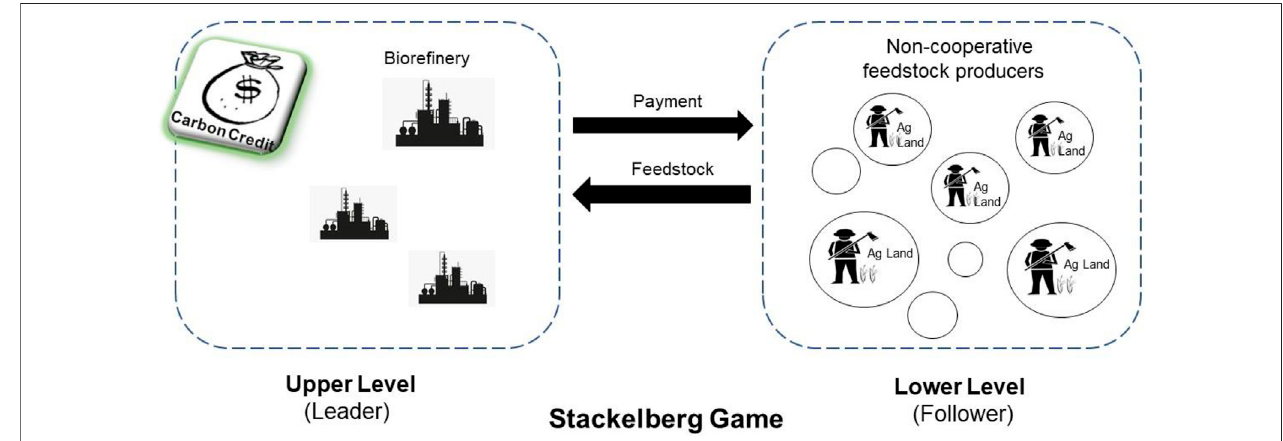
FIGURE 1 | The Stackelberg leader-follower game of the SAF feedstock supply chain. Note: Figure is adapted from Figure 2 in Yao et al.